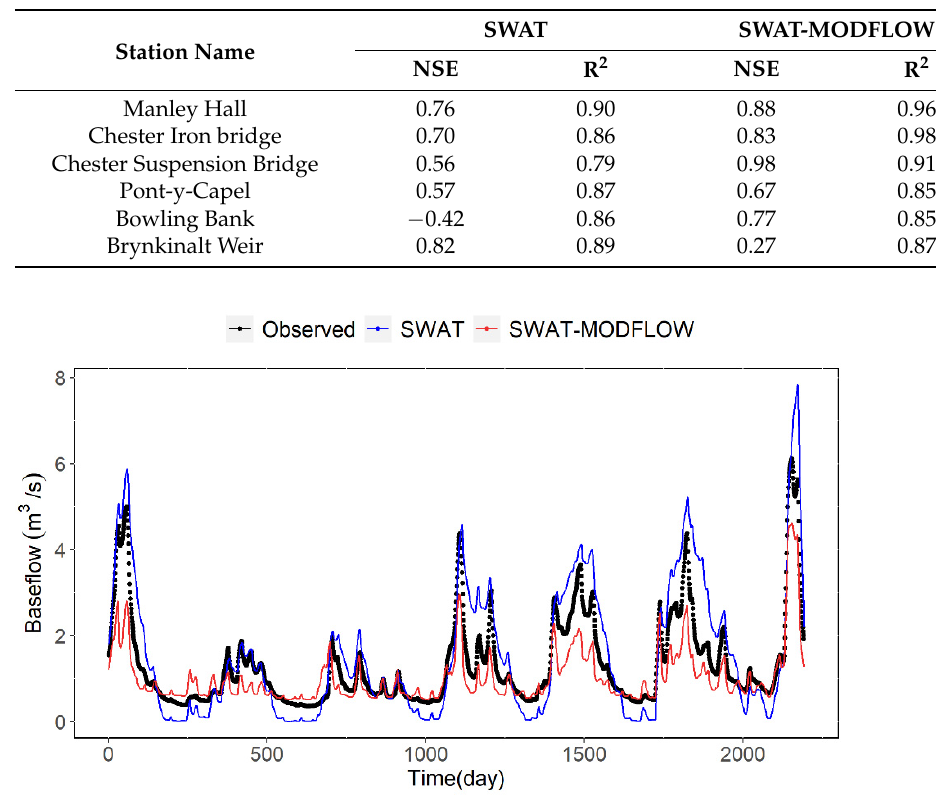
Figure 15. Comparison of simulated baseflow from the standalone SWAT model and the coupled SWAT-MODFLOW at Pont-y-Capel for the period of 1995–2000.